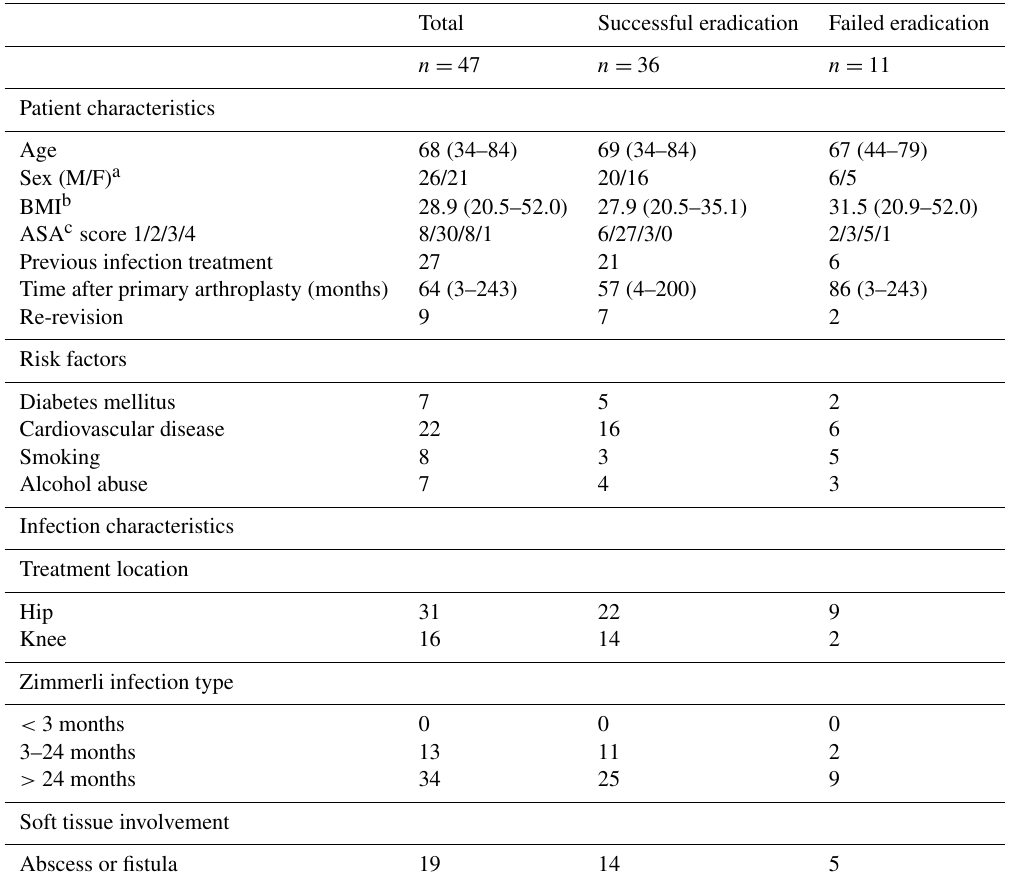
Table 1. Baseline